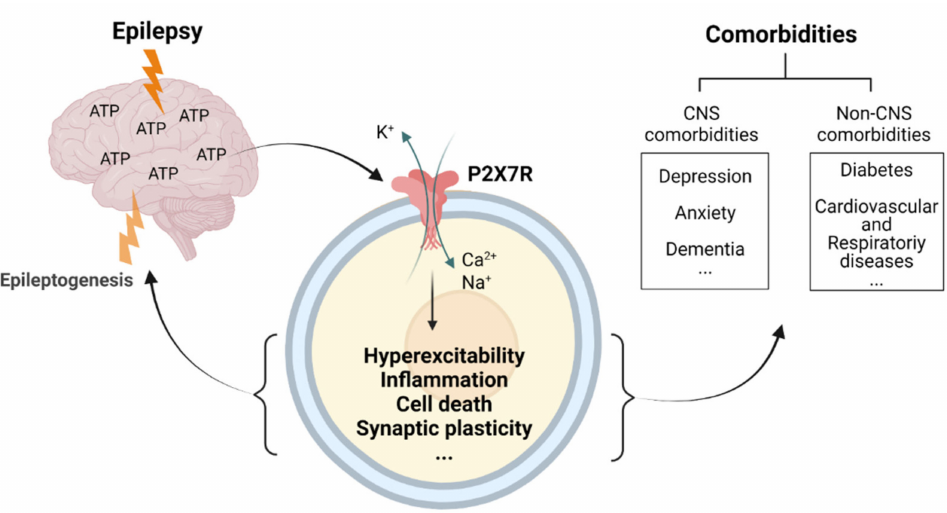
Figure 3. The ATP-P2X7 receptor axis as major convergence pathway linking hyperexcitability and associated comorbidities in epilepsy. Seizures and epilepsy lead to high extracellular concentrations of ATP in the brain-activating P2X7Rs. P2X7R activation in turn promotes several pathological mechanisms such as inflammation, cell death, aberrant synaptic plasticity, and changes in the release and uptake of neurotransmitters, driving epileptogenesis and contributing to the development of several comorbidities. Created with BioRender.com (accessed on 17 February